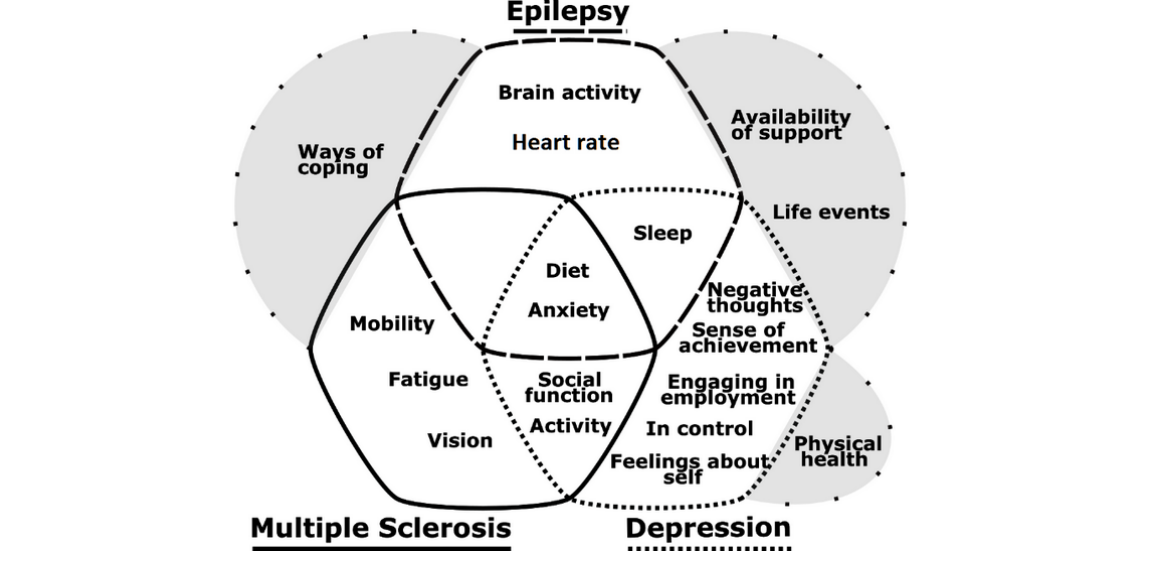
Figure 1. The unique and overlapping outcomes of importance for three chronic health conditions: major depressive disorder (ie, depression), epilepsy, and multiple sclerosis. Grey areas outside of the overlapping sections represent contextual factors either shared or uniquely mentioned by members of the focus